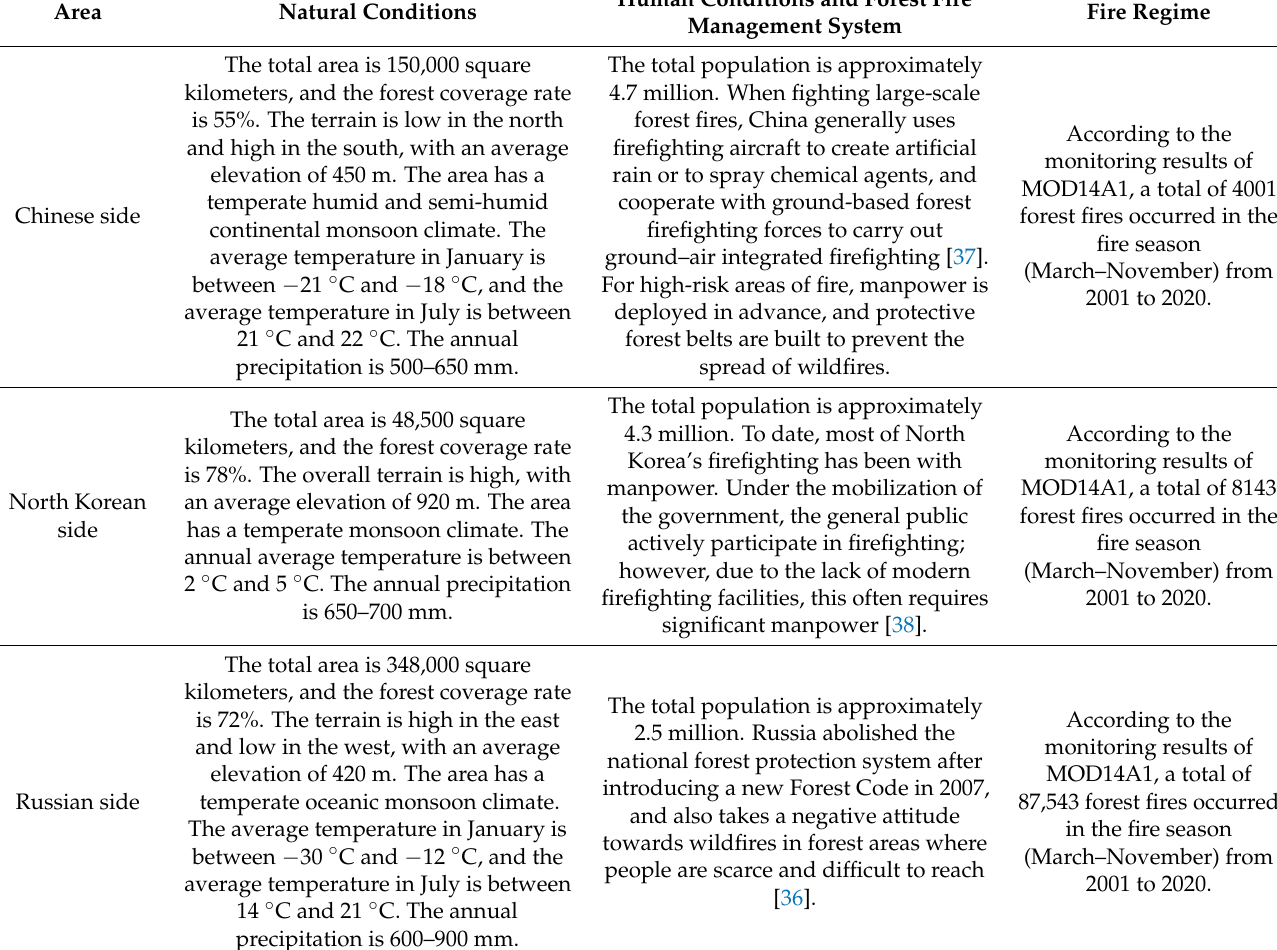
Table 1. Basic conditions of different countries in the study